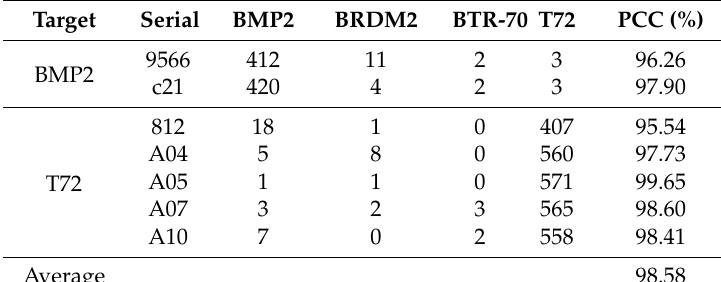
Table 6. Classification results of different configurations of BMP2 and T72.